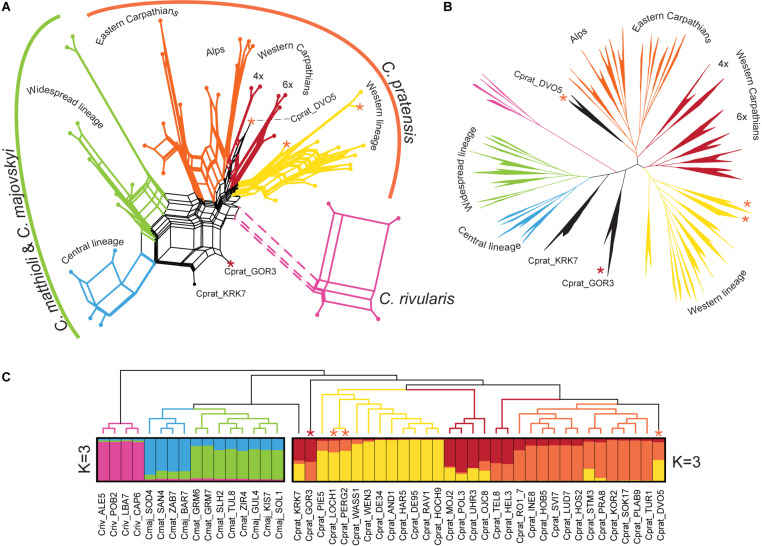
Genetic structure of Cardamine matthioli, C. majovskyi, C. rivularis, and C. pratensis inferred from Hyb-Seq data analyses. The coloring indicates the sample assignment to genetic clusters as inferred from STRUCTURE analyses: blue and green represent the Central and Widespread lineages of C. matthioli and C. majovskyi, respectively; purple represents C. rivularis; yellow, orange, and red represent the Western, Alpine-Bohemian–E Carpathian and W Carpathian lineages of C. pratensis, respectively. (A) Supernetwork representation of quartets generated in SuperQ, derived from 499 most informative maximum likelihood (ML) gene trees. (B) ML tree constructed from concatenated allele sequences obtained by read-backed phasing from all 963 genes in RAxML-NG. All major clades received bootstrap support greater than 95%. (C) Bayesian model-based clustering (STRUCTURE) based on SNP data from two partial datasets of C. matthioli, C. majovskyi, C. rivularis (on the left), and C. pratensis (on the right); ML tree constructed using the concatenated genes (as in B) is displayed as a cladogram on top. Samples with significant admixture (hybrid origins) between the species or lineages are shown with black branches. Asterisks denote samples differently placed in microsatellite analyses, and their colors indicate the assignment based on microsatellite data. For accession codes see Supplementary Data 1.